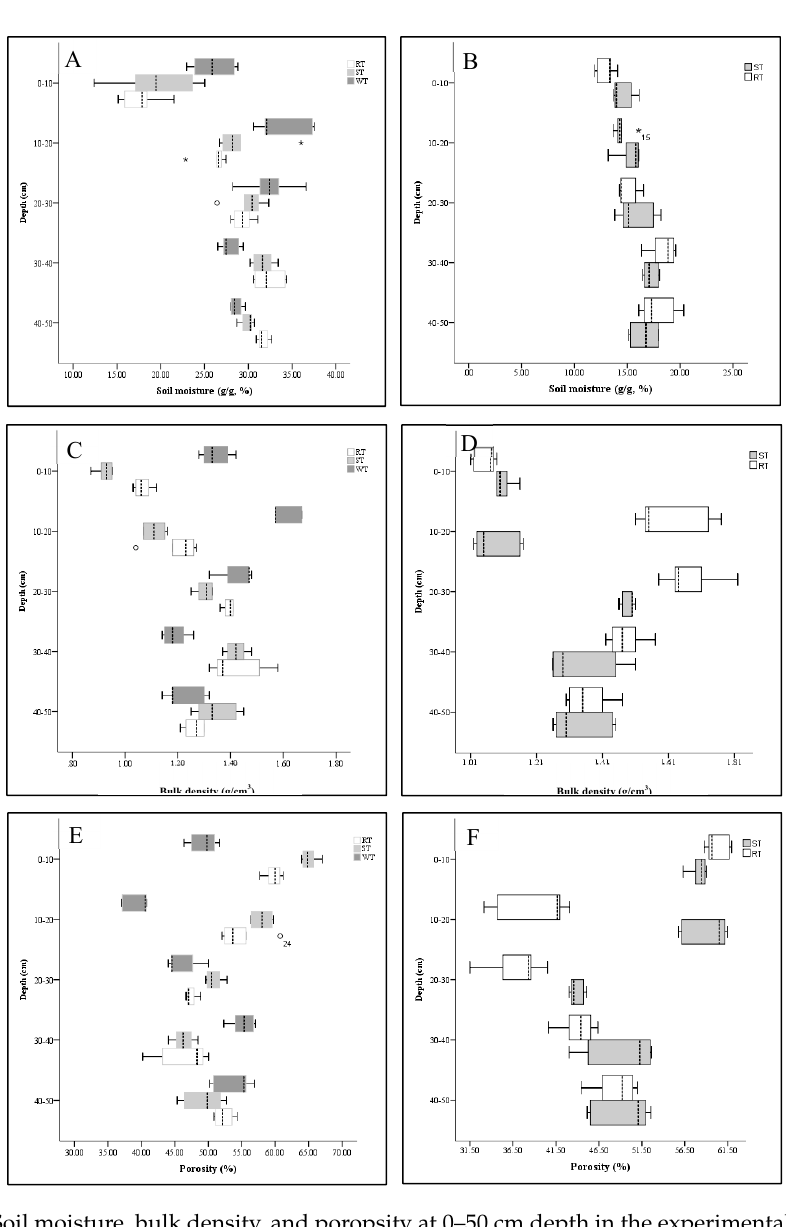
Figure 1. Soil moisture, bulk density, and poropsity at 0–50 cm depth in the experimental field after tillage and before sowing, in 2013 ( A , C , E ) and 2014 ( B , D , F ). WT, without tillage, RT, rotary tillage, ST, subsoil tillage.